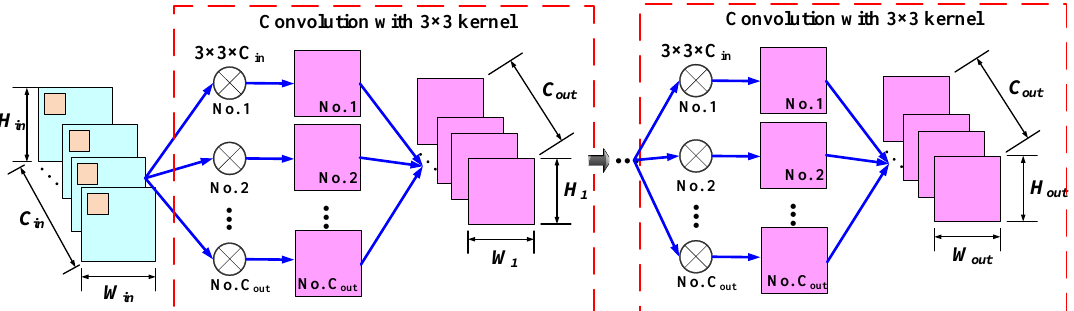
Figure 4. The procedure of the kernel decomposition convolution layer that decomposes the large convolution kernels into 𝑀 stacked 3 × 3 filters. Given the 𝑊 𝑖𝑛 × 𝐻 𝑖𝑛 × 𝐶 𝑖𝑛 feature map, 𝐹 𝑖𝑛 , 𝐶 𝑜𝑢𝑡 small convolution kernels with the size of 3 × 3 × 𝐶 𝑖𝑛 are applied to generate the first intermediate feature map with the size of 𝑊 1 × 𝐻 1 × 𝐶 𝑜𝑢𝑡 . Subsequently, the first intermediate feature map is convolved successively with 𝐶 𝑜𝑢𝑡 small convolution kernels with the size of 3 × 3 × 𝐶 𝑜𝑢𝑡 for 𝑀 − 1 times, and the output feature map 𝐹 𝑜𝑢𝑡 with the size of 𝑊 𝑜𝑢𝑡 × 𝐻 𝑜𝑢𝑡 × 𝐶 𝑜𝑢𝑡 is produced.